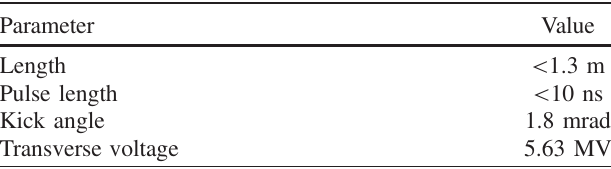
TABLE II. Kicker main parameters for the application de- scribed in Sec. III. The pulse length should be slightly shorter than the rf period (10 ns for 100 MHz) because of the finite bunch length. The transverse voltage (see text) is derived from the beam energy of 3.13 GeV ( δ ¼ þ 4 . 3% ) and the kick angle of 1.8 mrad.